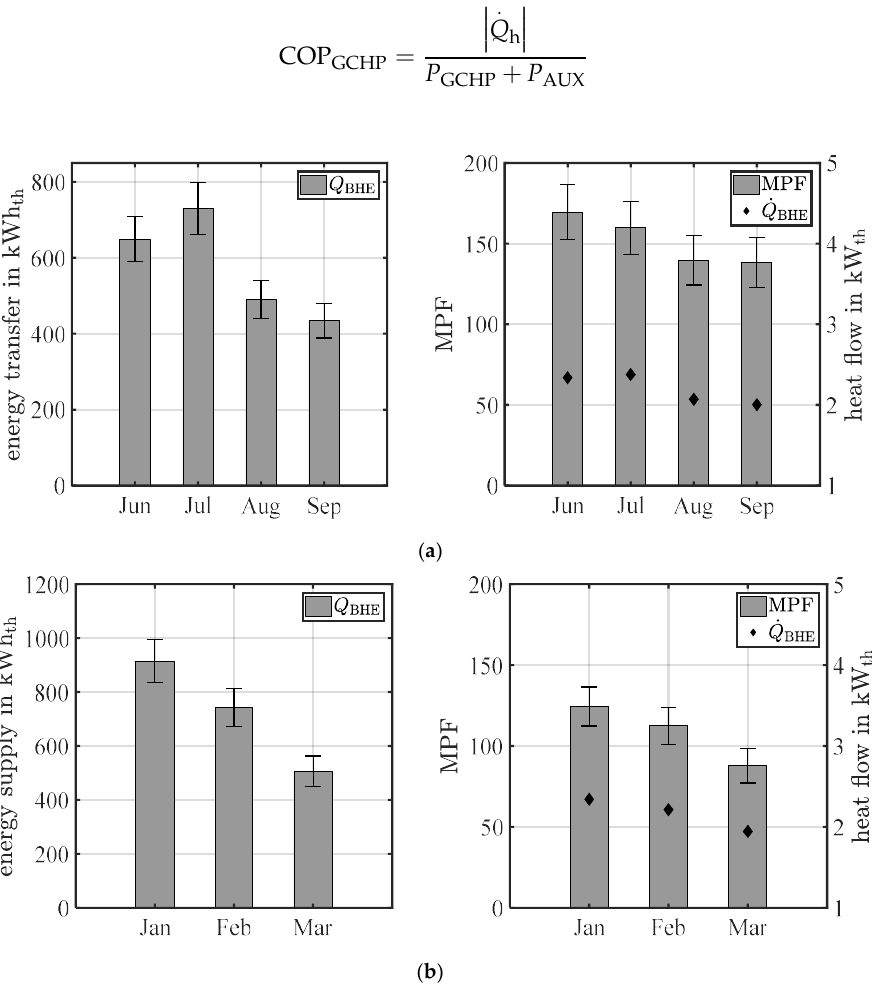
Figure 7. Thermal energy transfer at the BHE ( left ) and performance parameters of the BHE ( right ) for the investigated periods: ( a ) cooling period; ( b ) heating period.